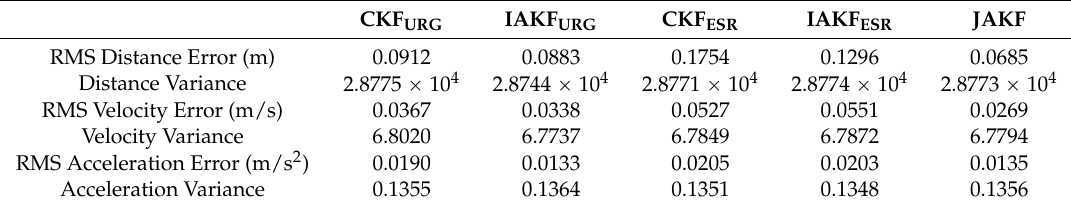
Table 4. Error comparisons of CKF, IAKF, and JAKF in second experiment.